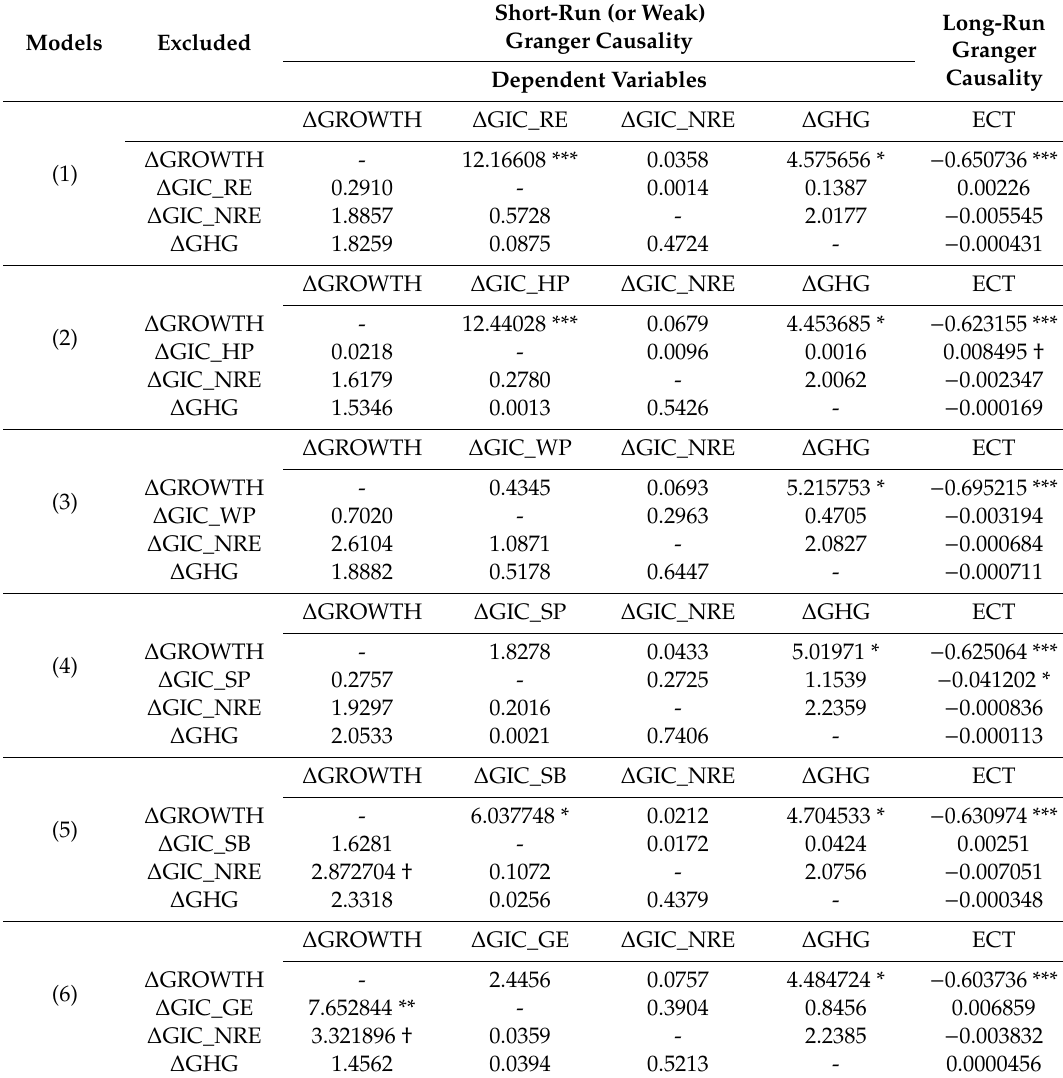
Table 16. Panel causality